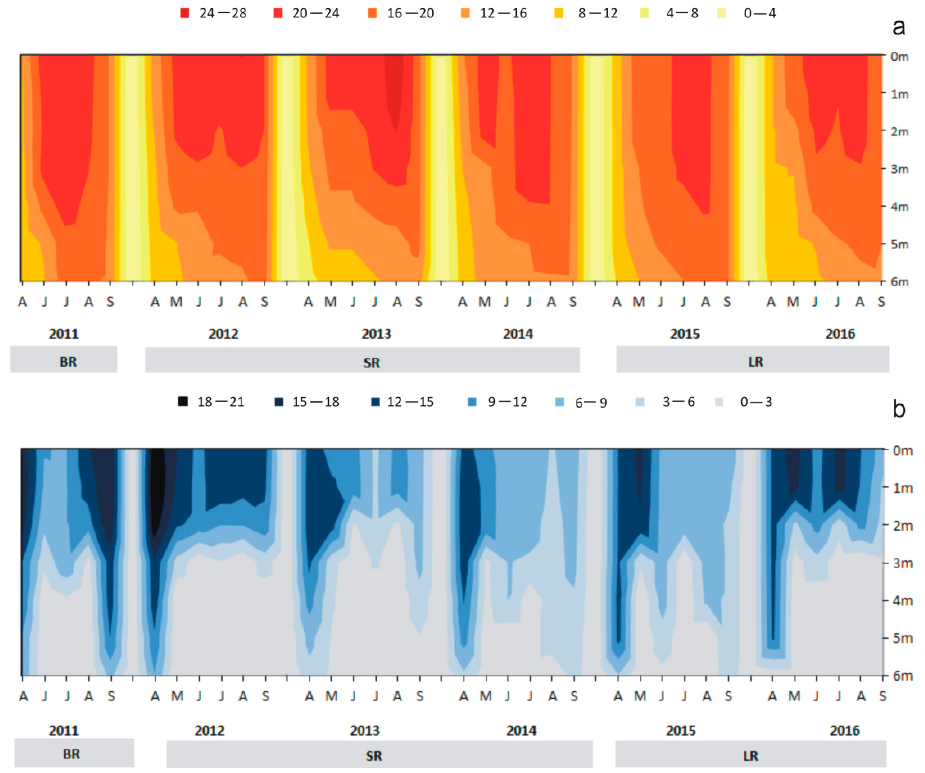
− 1 ) ( b ) in the depth 2 L